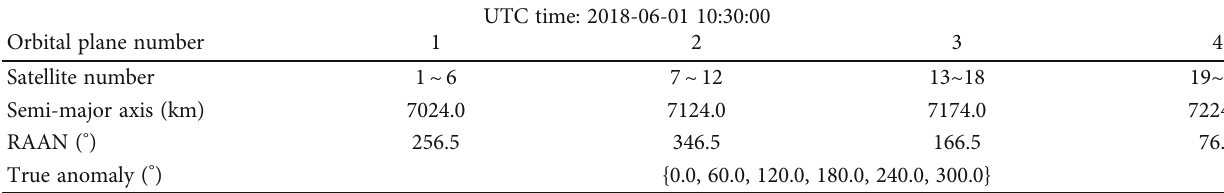
Table 2: Main initial orbital elements of the satellite in